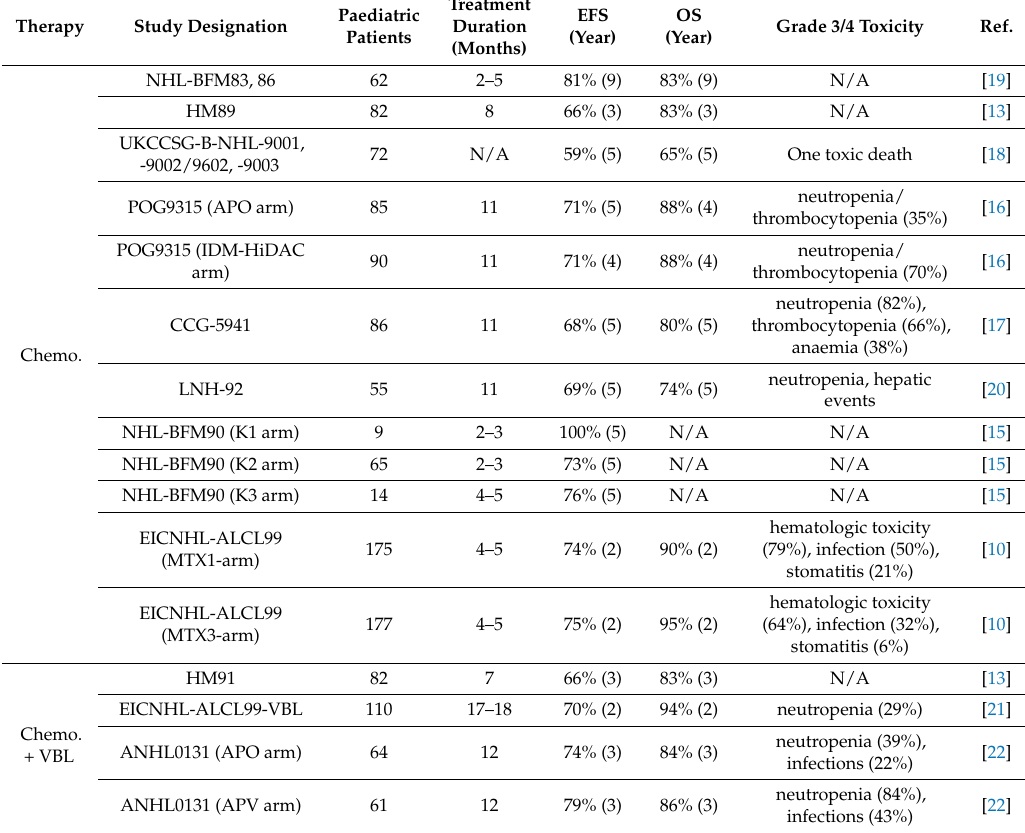
Table 1. Treatment outcomes for paediatric patients with Anaplastic Large Cell Lymphoma (ALCL) after frontline multi-agent chemotherapy with or without methotrexate (MTX) or vinblastine